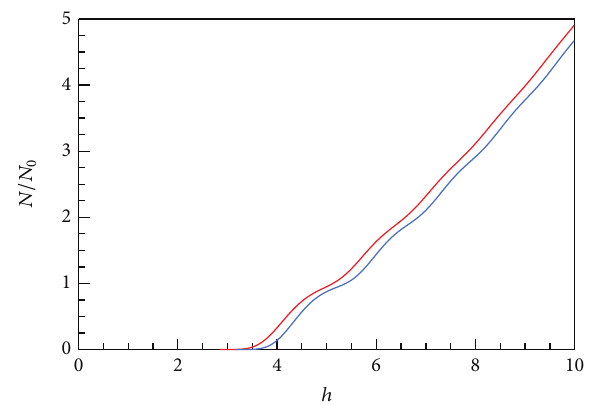
Figure 6: Predicted exit neutron count 𝑁(ℎ)/𝑁 0 for the mirror similar to the one in Figure 5 with roughness generated using Monte Carlo simulations for the 1D Ising model. The roughness amplitudes are 𝜂 = 0.3 (red) and 𝜂 = 0.4 (blue) and the correlation radius 𝑟 = 2 . One can make steps more pronounced by further increasing 𝜂